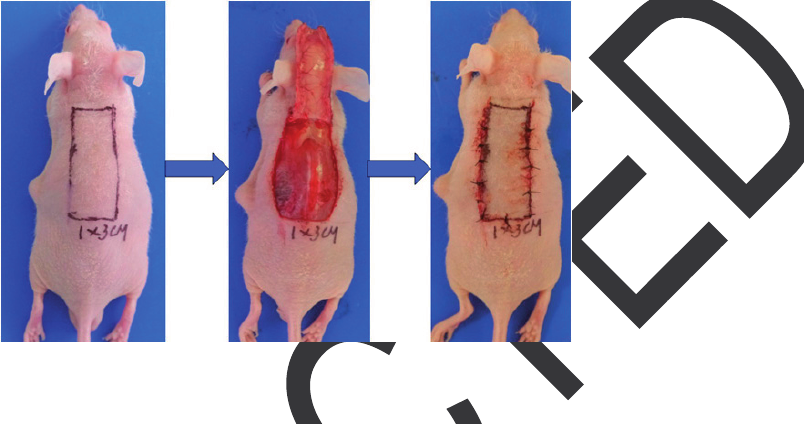
Figure 5. The reproducible ischaemic flap models were established in 3 cm length and 1 cm width with the main vessels coagulated by cautery in the